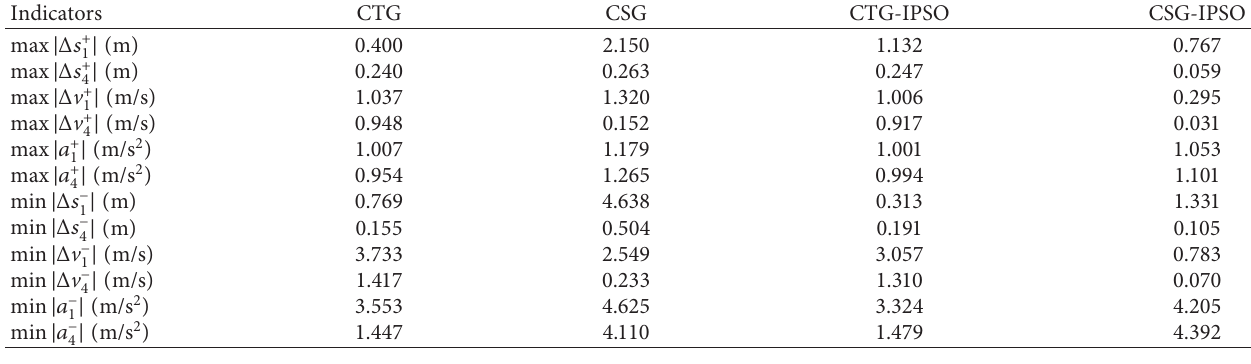
Figure 3: Optimization result of CTG-IPSO scheme and CSG-IPSO scheme: (a) CTG-IPSO and (b) CSG-IPSO. Table 1: Performance results of platooning controllers.